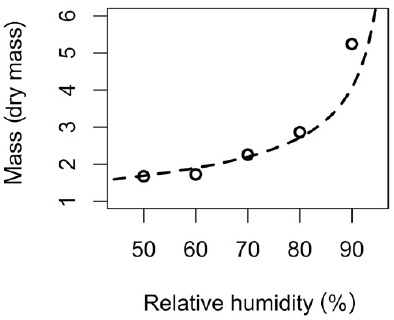
Figure 5. Comparison of humidograms from pure sulfuric acid and the Nicaragua volcanic plume. Circles denote the Nicaragua plume aerosol, and the dashed line represents the modelled sulfuric acid humidogram from the E-AIM model.